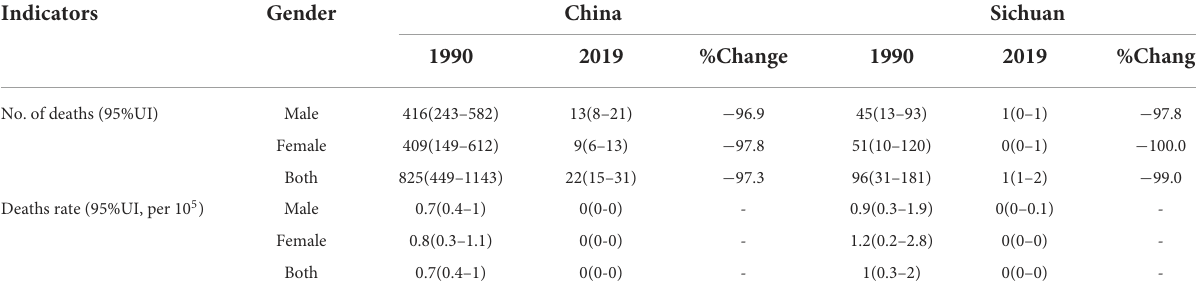
TABLE 2 Asthma deaths and deaths rate under 5 years old, 1990 to 2019 with percentage change.